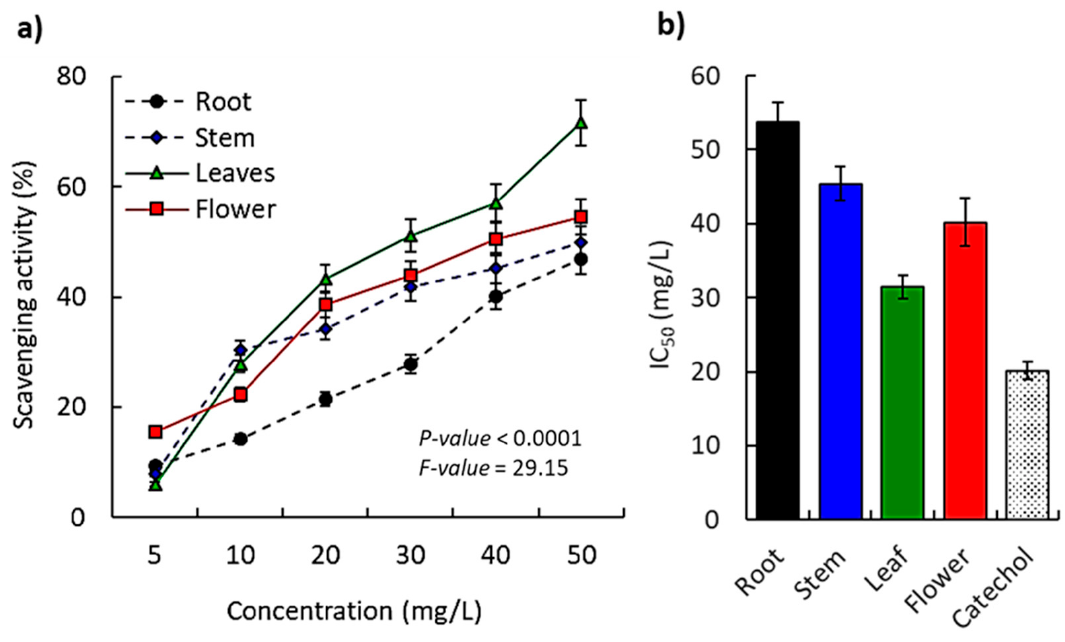
Figure 5. DPPH radical scavenging activity at different concentrations of the different parts of M. longipetala methanol extract ( a ), and IC 50 values ( b ). Values are average ( n = 3 ), and the bars represented the standard deviation.